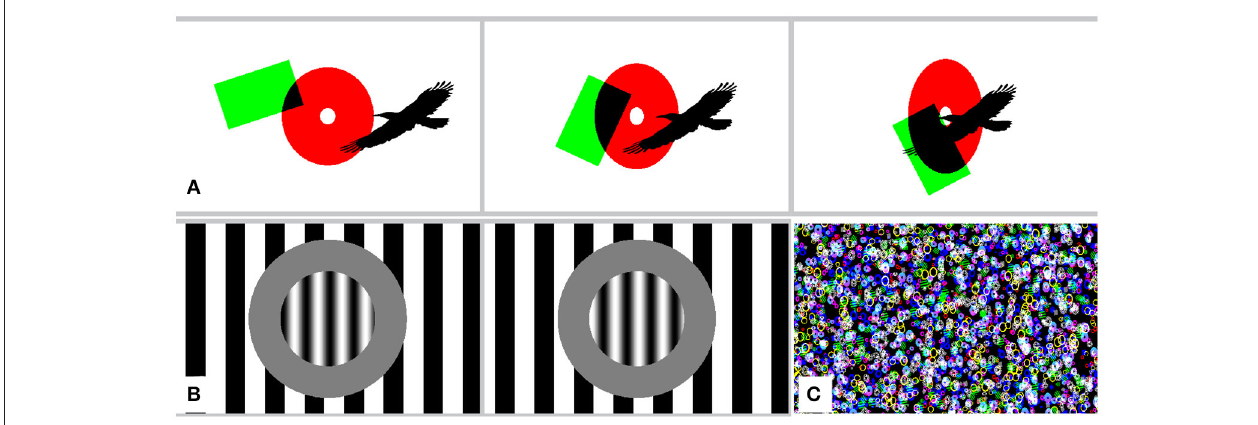
FIGURE 6 | Sample frames taken from moving (shifting and rotating) patterns: (A) Moving and deforming shapes, (B) Square grating and sinusoid grating, separated by an annulus, and moving in opposite directions. Note that implementing phase inversion is also straightforward. (C) 5,000 shapes with random size, orientation, and motion, rendered without performance